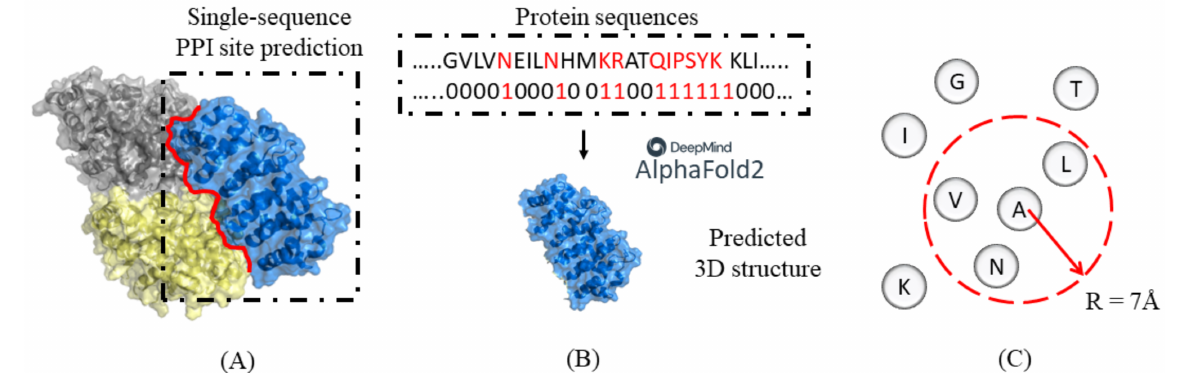
Figure 1. ( A ) The prediction task of single-sequence PPI site prediction. ( B ) The figure showed the protein 3D structure predicted from primary protein sequences using AlphaFold2. ( C ) In the spatial filtering strategy, “neighborhood” is defined as the entirety of all residues in a space with a certain distance centered on the C α atom of the current